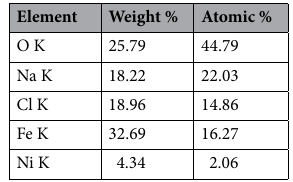
Table 2. Relative elemental mass of synthesized NFN’s.